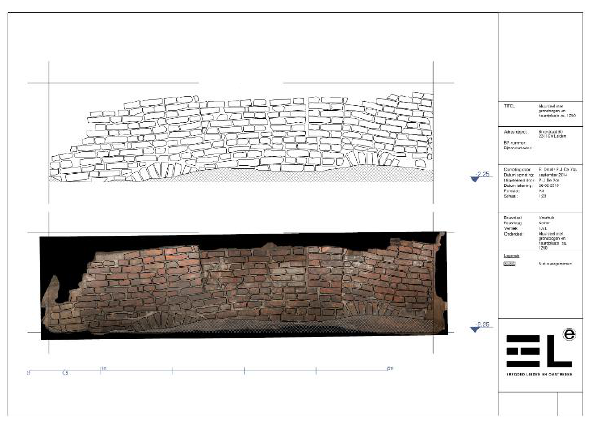
Figure 7. Brick wall dated circa 1250. Orthophoto traced in BricsCAD to amplify key details. (Breestraat 90, Leiden)